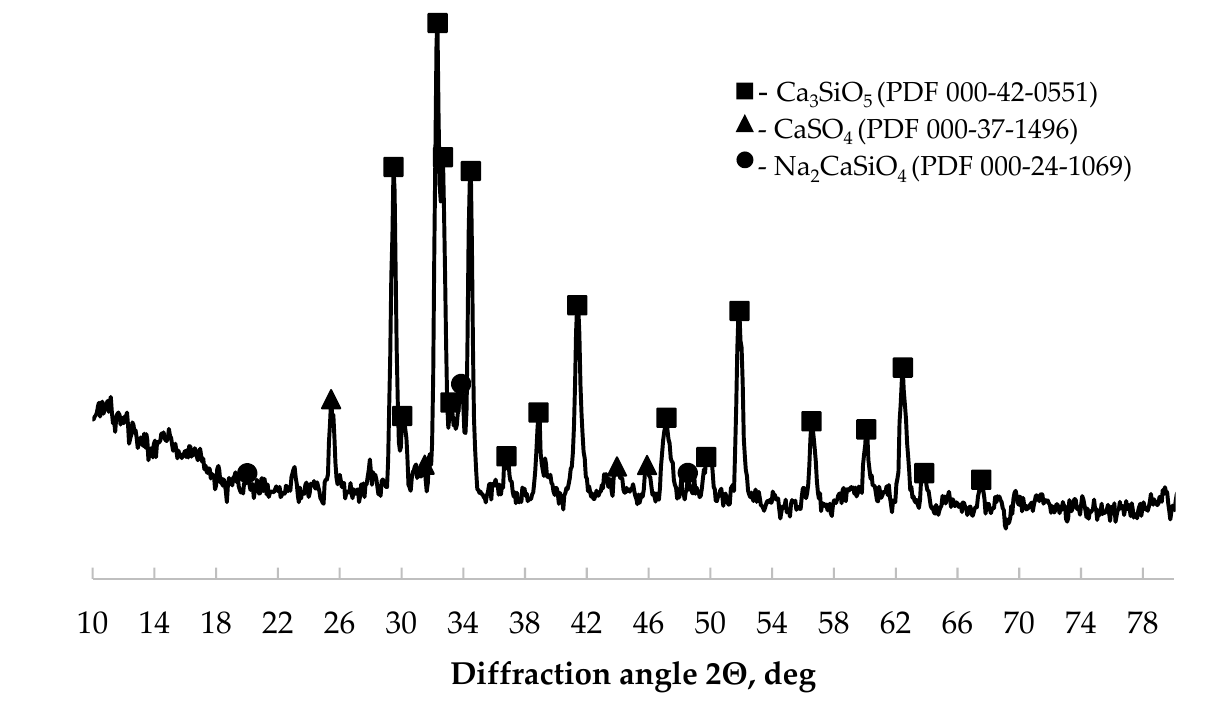
Figure 2. X-ray diffraction pattern of Portland cement CEM I 42.5 Figure 2. X-ray di ff raction pa tt ern of Portland cement CEM I 42.5 N.